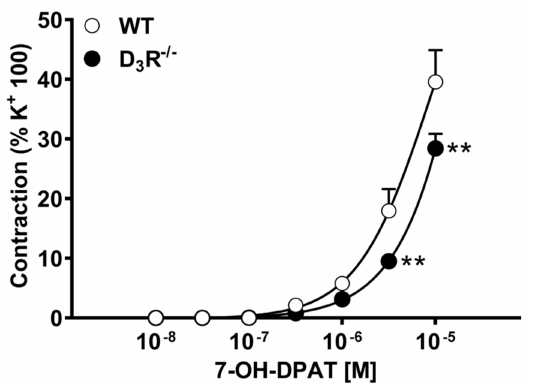
Figure 2. Vasoconstriction induced by 7-hydroxy-2-dipropylaminotetralin (7-OH-DPAT), in aortic segments isolated from wild-type (WT) and D3R − / − mice. Each curve (with vertical bars represent- ing standard errors) represents the average from 8–10 preparations. Two-way ANOVA (genotype: F (1,294) = 13.4, p = 0.0003; agonist conc.: F (6,294) = 108, p < 0.0001; genotype x agonist conc. F (6,294) = 3.55, p = 0.0021) and Bonferroni’s test (** p < 0.01 vs.